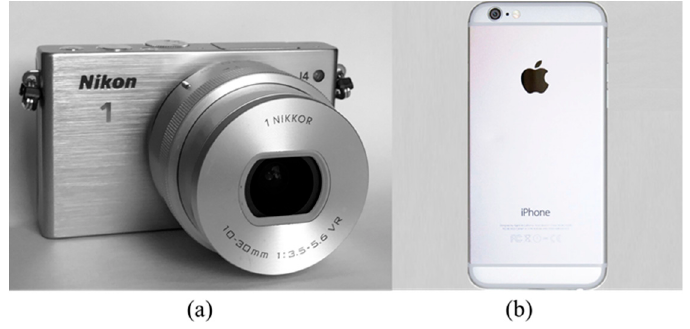
Figure 1. ( a ) Nikon 1 J4 camera with a 3x optical zoom lens; ( b ) iPhone 6 mobile phone camera.